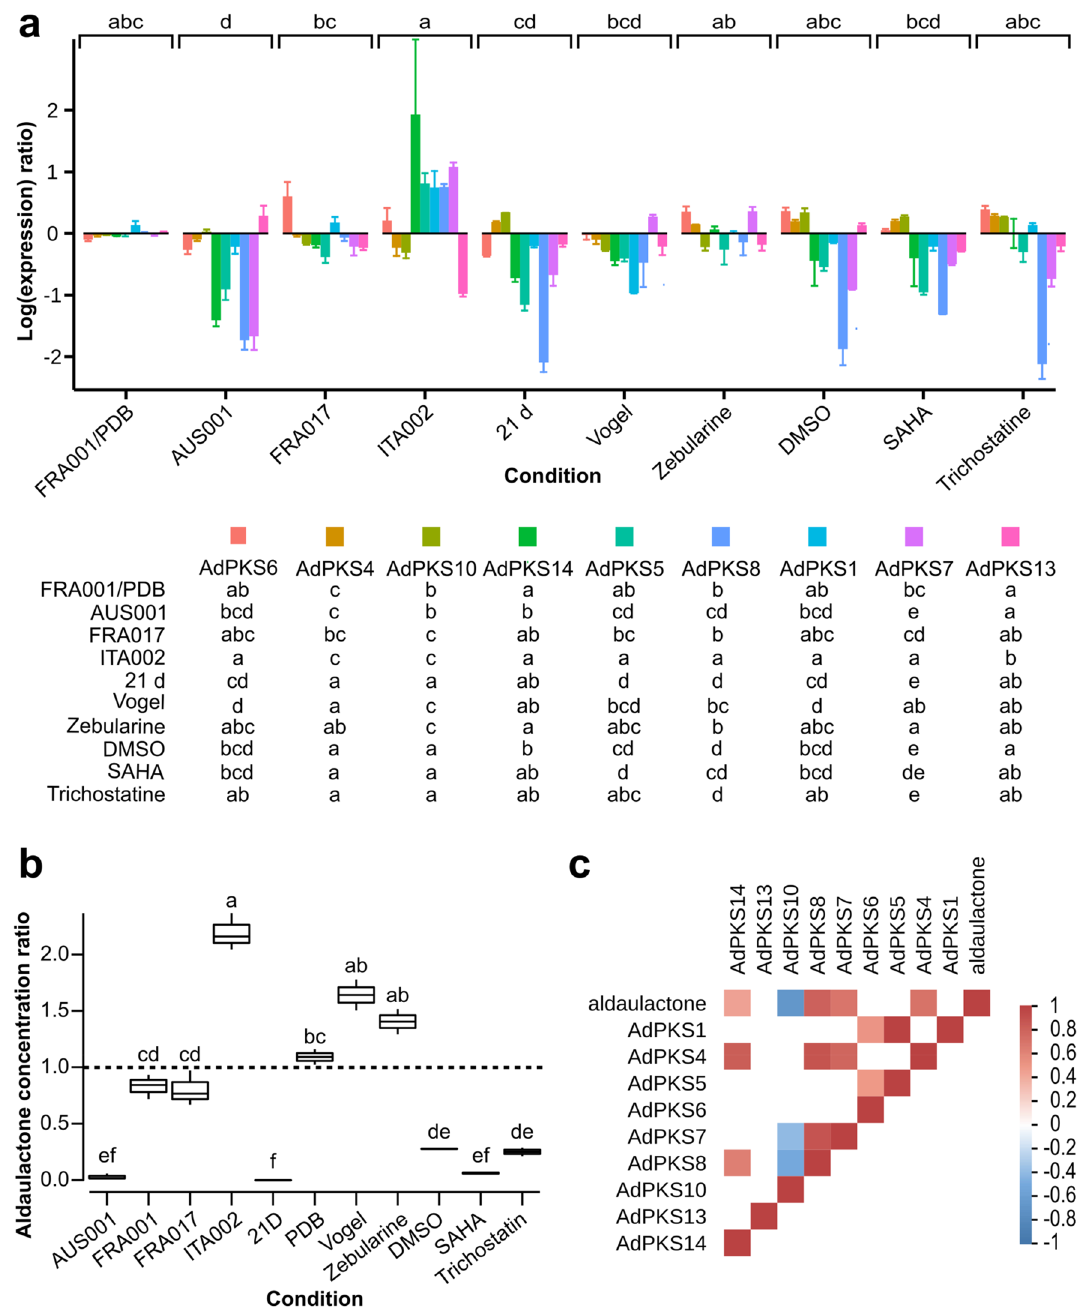
Figure 8. Relative expression of AdPKS genes and Aldaulactone production. ( a ) Relative expression of AdPKS genes by A. dauci . RT-qPCR was performed on RNA from 60-h-old mycelium from different strains and cultivated in various conditions. Four A. dauci strains (AUS001, FRA001, FRA017 and ITA002) were grown in PDB medium. FRA001 was also grown in different conditions: 21 days in PDB medium without shaking (21D), minimal medium (Vogel), minimal medium with DMSO (DMSO), or minimal medium with chemical inhibitors of epigenetic regulation (Zebularine, SAHA, Trichostatin) in DMSO. The relative expression of AdPKS1, AdPKS4, AdPKS-NRPS5, AdPKS6, AdPKS7, AdPKS8, AdPKS10, AdPKS14 were studied. The expression ratio was calculated with FRA001 grown in PDB as a control sample and normalized thanks to mean expression of three housekeeping genes ( EF1 , actin and G3P ). Data presented are the averages on at least two biological replicates and three technical replicates; the error bars represent standard errors. Data were analyzed by Kruskall-Wallis test ( p < 0.5) followed by a post-hoc test using the Fisher’s least significant difference with Bonferroni correction (culture modalities or culture modalities and gene as factors). Different letters indicate significant differences. Letters above the figure correspond to culture modalities for all genes. Letters bellow the figure correspond to culture modalities for each gene. ( b ) Aldaulactone yield for A. dauci strains in various culture conditions. From the same A. dauci cultures as in A., aldaulactone absolute quantification was performed from an organic extract of the culture medium by HPLC–DAD with a standard curve. A ratio was calculated for all the quantifications relative to the mean quantity of aldaulactone in FRA001 60 h cultures in PDB medium. ( c ) Correlation matrix of AdPKS gene expression ratio and aldaulactone yield ratio presented in ( a ) and ( b ). Spearman coefficient was calculated. Only significant correlations are shown, if non-significant they appear blank. Color in each cell represents the value of correlation